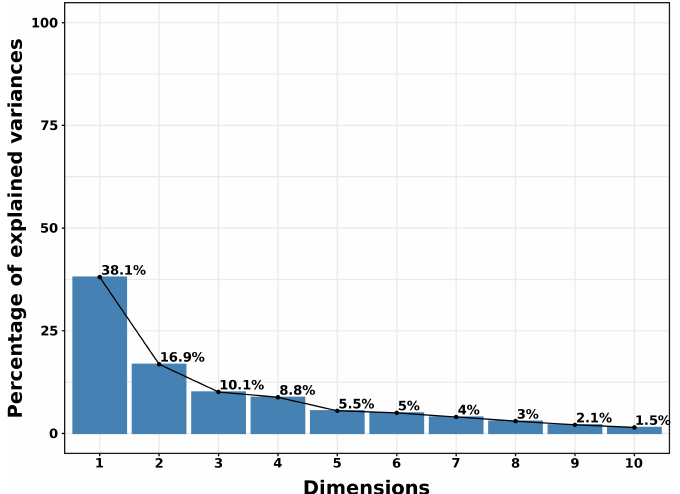
Figure 14. Variance related to eigen